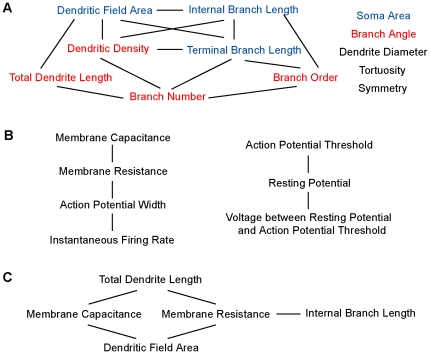
Relationship among morphological and physiological parameters.Highly correlated parameters were connected by the lines. Unlinked parameters are relatively independent from each other. Please refer to Table 2, 3 and 4 for the degrees of correlation. There were strong correlations among morphological parameters (A), among physiological parameters (B), and between a few morphological and physiological parameters (C). In (A), colors indicate parameters with different developmental patterns, i.e. peaking at P8 (red), peaking between P16–20 (blue), and stable through development (black).